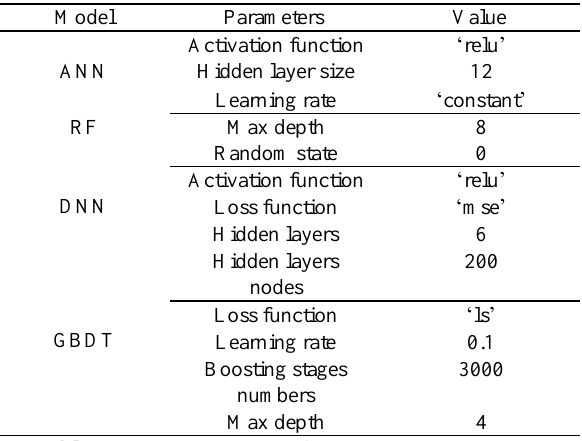
Table 1 . Parameter settings of machine learning